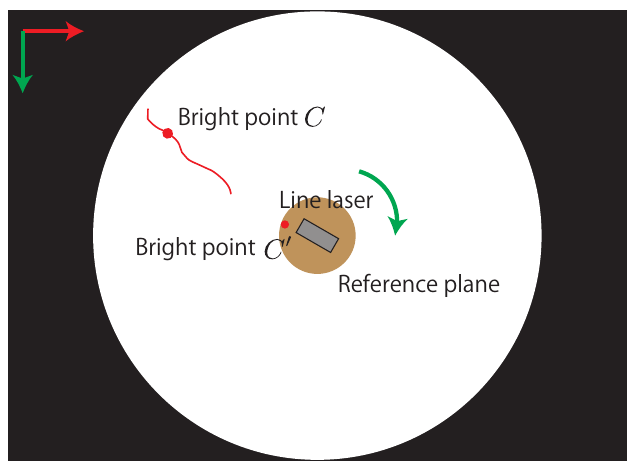
Figure 5. Overview of image obtained using high-speed omnidirectional